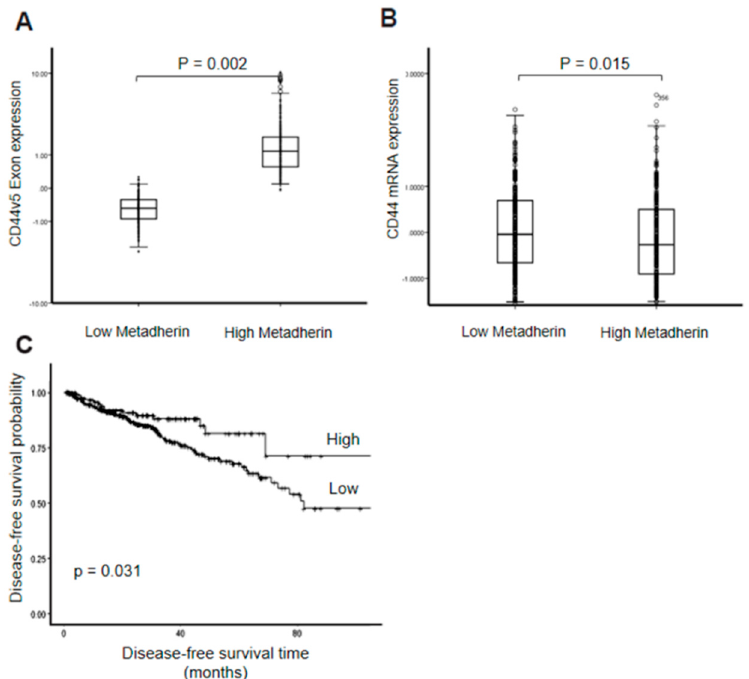
Figure 5. Increased metadherin expression is associated with increased CD44v5 exon expression and altered disease free survival. ( A ) CD44v5 mRNA expression levels between The Cancer Genome Atlas (TCGA) prostate adenocarcinoma (PRAD) patients separated by median metadherin expression. ( B ) Overall CD44 mRNA expression between patients separated by median metadherin expression ( C ) Kaplan-Meier showing disease-free survival time in patients segregated by CD44v5 mRNA expression. P -values were calculated using a Student’s two-tailed t -test and a log-rank test